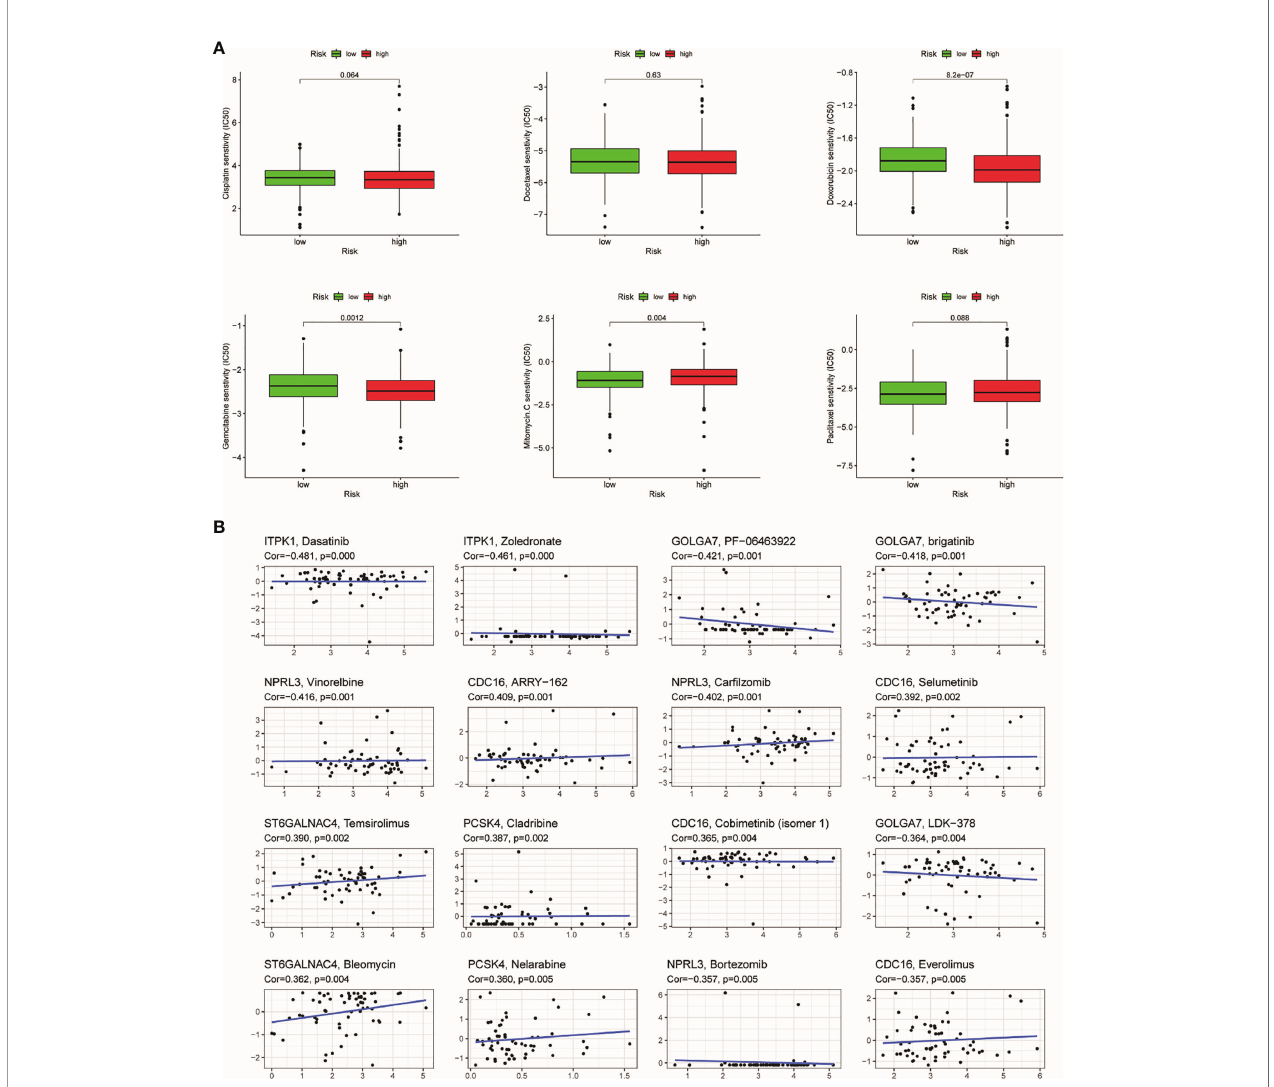
FIGURE 11 | The results of chemosensitivity analysis. (A) Association between the risk score and chemosensitivity in UCEC. The box plots of the estimated IC50 for cisplatin, docetaxel, doxorubicin, gemcitabine, methotrexate, and paclitaxel were shown in the two groups. (B) Scatter plot of relationship between prognostic gene expression and drug